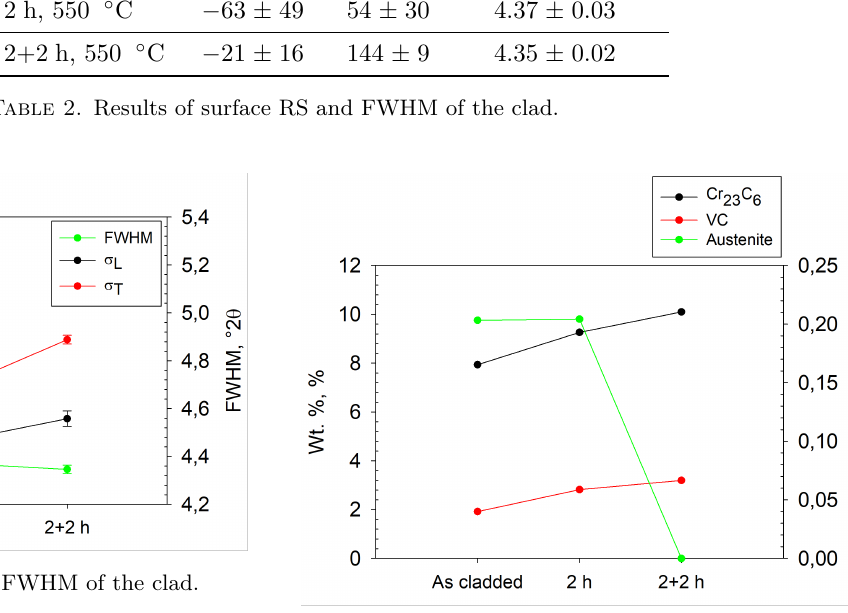
Figure 4. Effect of annealing on the phase content of the